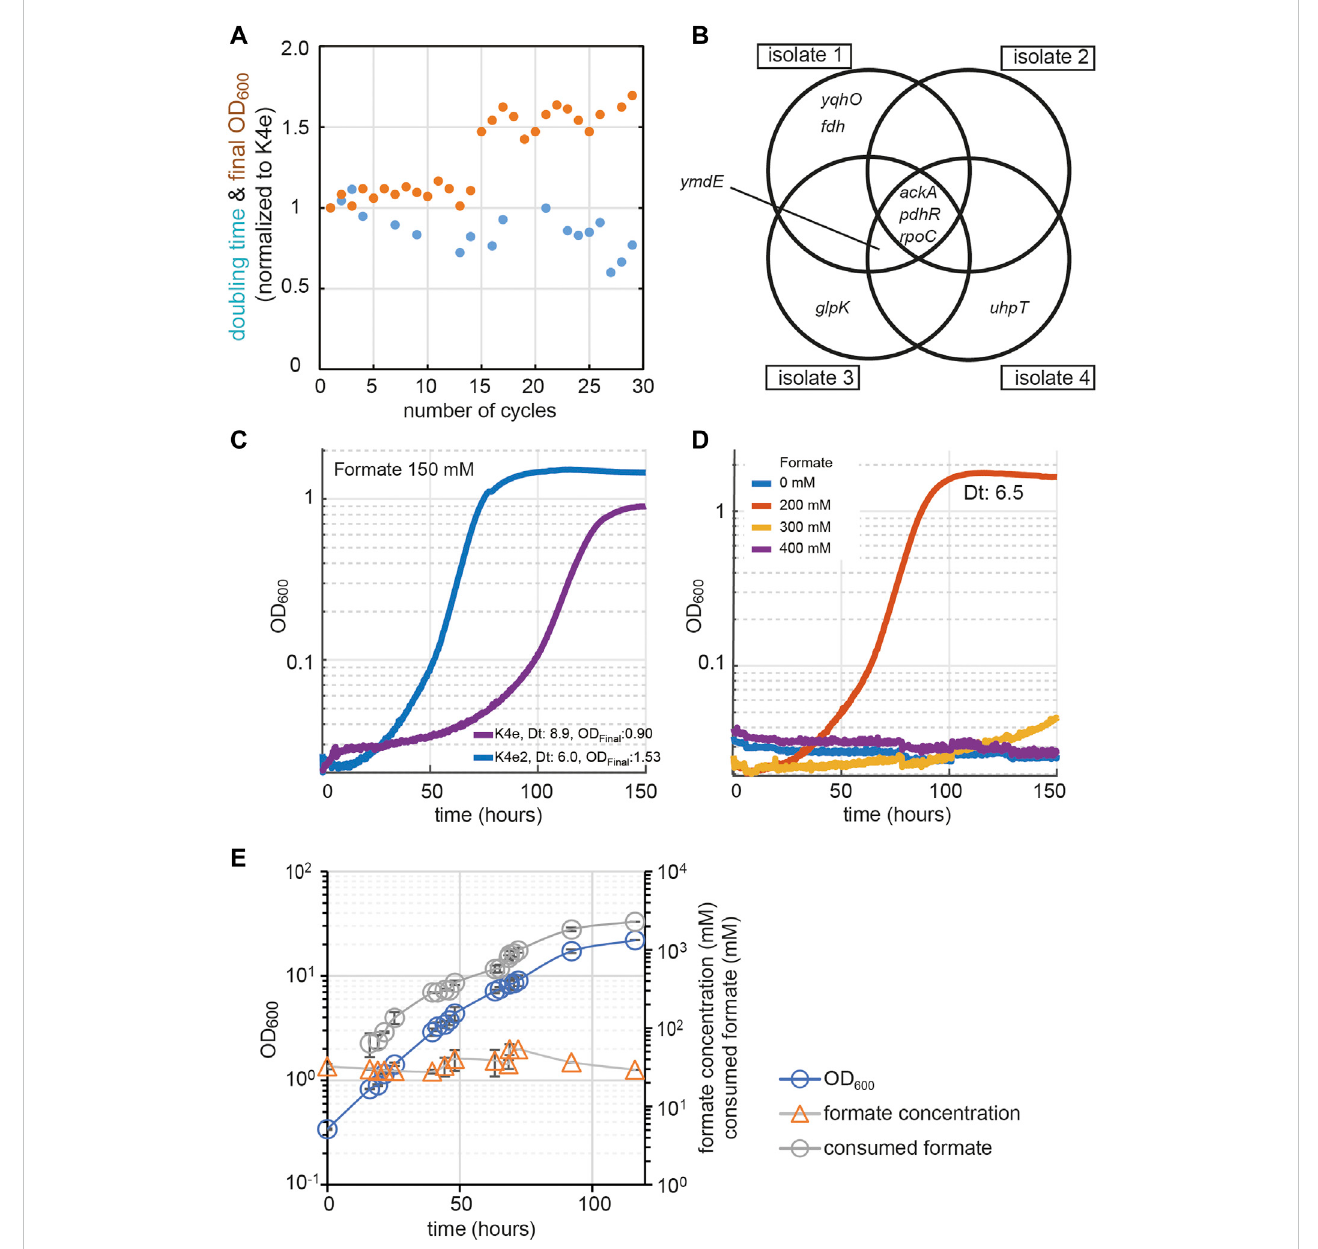
FIGURE 2 Evolution approaches for enhancing growth on formate. (A) Evolution from K4e to K4e2 via laboratory evolution was conducted in test tubes in M9minimalmediumwith90 mMformateinthepresenceof10%CO 2 .FinalOD 600 (orangecircle)anddoublingtimes(bluecircle)werenormalizedtoK4e. (B) All identi fi ed mutated genes obtained after 30 cycles of re-inoculation. Only newly identi fi ed mutations are shown compared with parental strain K4e. (C) Growth pro fi le comparison between evolved strains. (D) Formate tolerance test of K4e2. (E) Fed-batch cultivation of strain K4e2 in a bioreactor with pH control. Feeding and pH control were achieved by pumping 10 M of formic acid. List of genes: pdhR , pyruvate dehydrogenase complex regulator; ymdE , uncharacterized protein; ackA , acetate kinase; yqhO , bio fi lm formation related gene; rpoC , RNA polymerase subunit beta; glpK , glycerol kinase; Experiments (C,D) were carried out at 10% CO 2 in 96-well plates in triplicates, displayed results are averages with errors < 5%. The corresponding doubling times (Dt) are shown in the fi